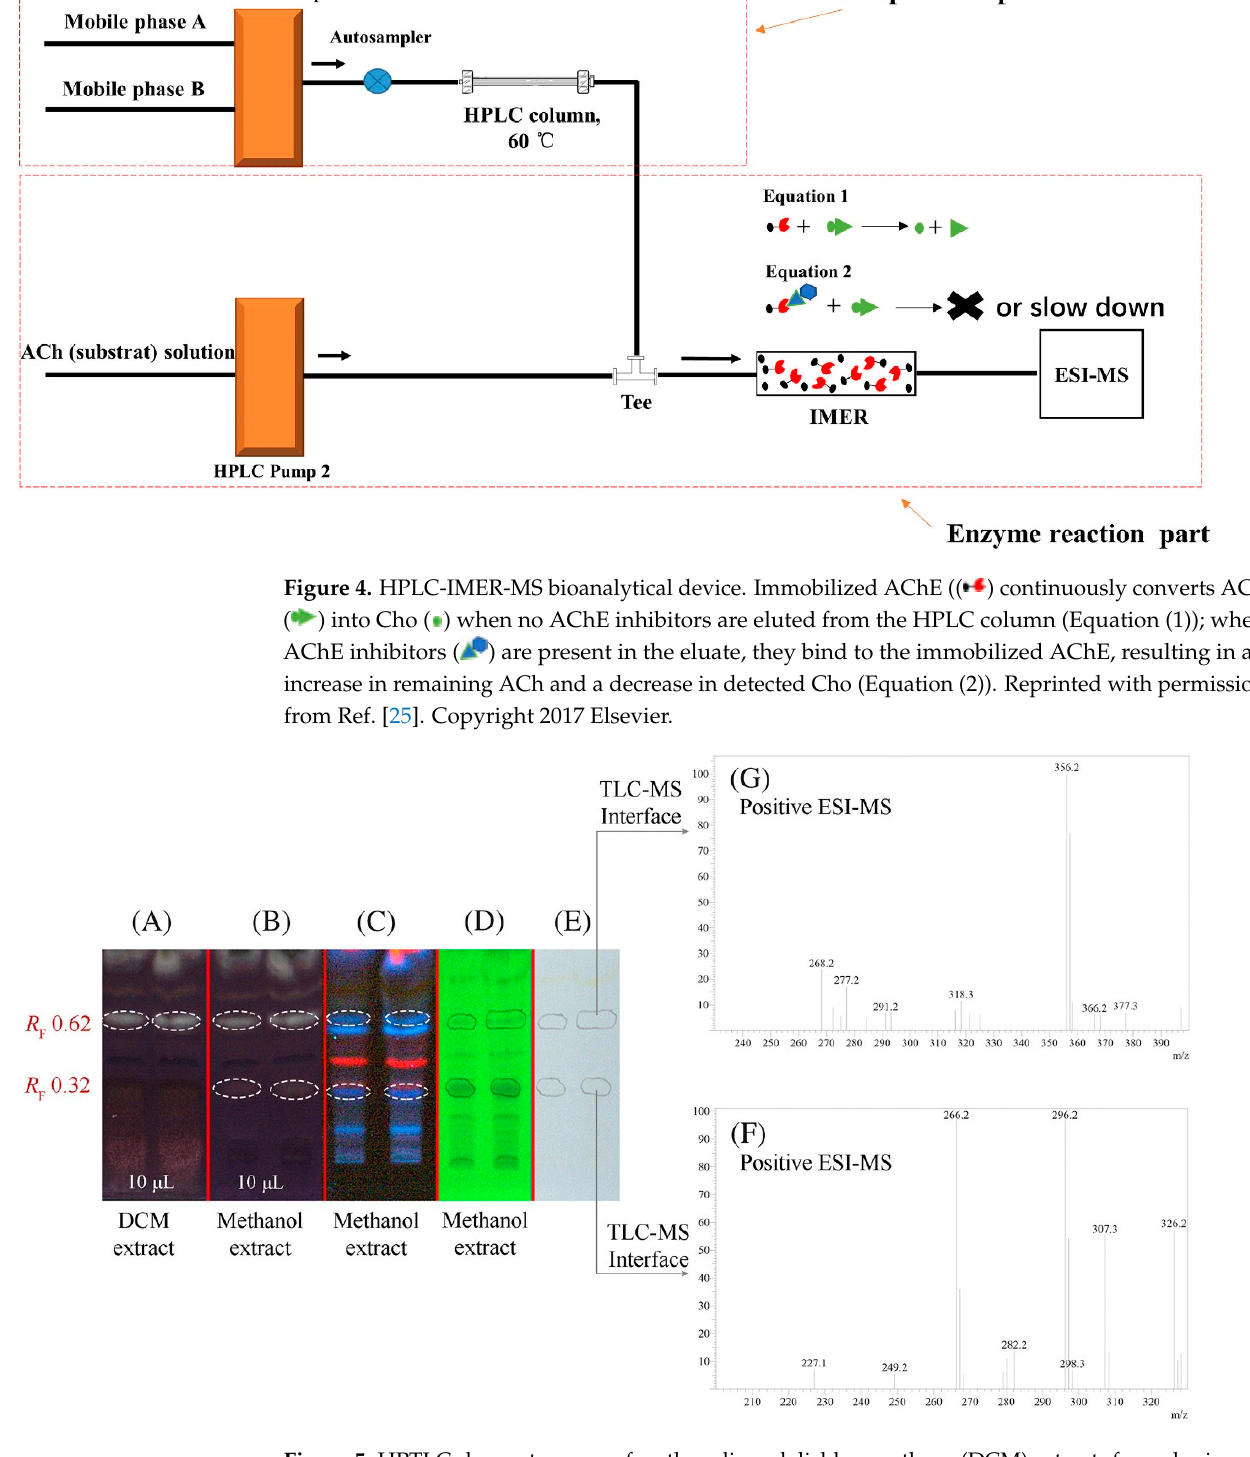
Figure 5. HPTLC chromatograms of methanolic and dichloromethane (DCM) extracts from cherimoya peel on silica gel 60 F 254 plates using a mobile phase composed of chloroform/methanol/ethyl acetate (80:14:6, v / v / v ). HPTLC-acetylcholinesterase bioassay photo-documented under white light of dichloromethane ( A ) and methanolic extract ( B ); photo-documentation at 366 nm-fluorescence ( C ) and 254 nm-UV ( D ); selected bands marked with soft pencil for elution to MS via TLC-MS interface ( E ) and ESI-MS spectra of selected bands ( F , G ). Reprinted with permission from Ref. [44]. Copyright 2019